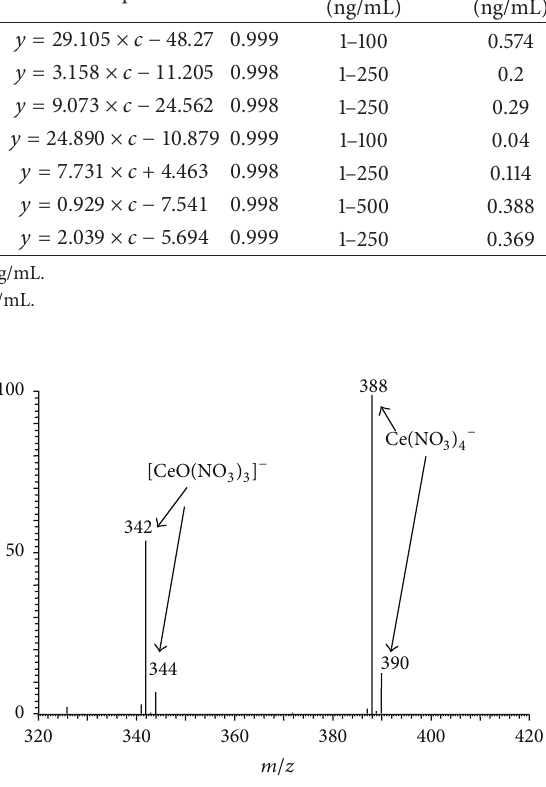
Figure 4: The MPT mass spectrum of cerium collected on the MPT- LTQ-MS in negative mode. A 10 mg/L cerium standard solution was